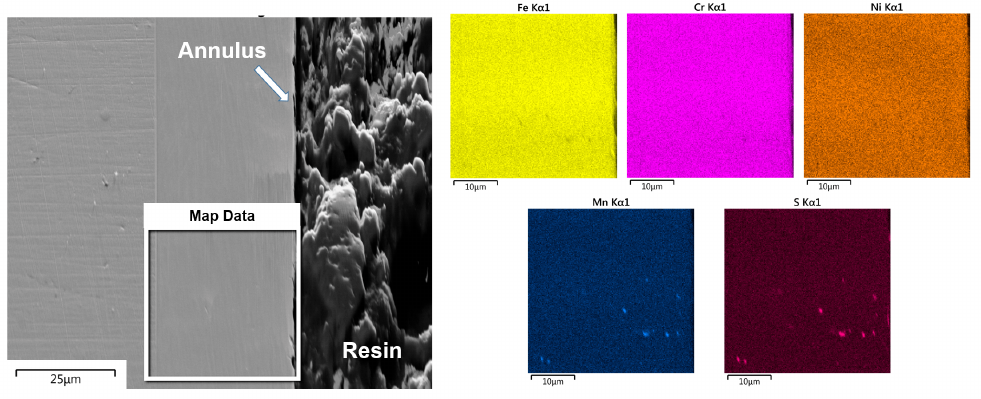
Figure 10. Elemental mapping of as-machined FT1. The analyzed region is from around the annulus, where the deformed layer was noted in Figure 6(a,a’).